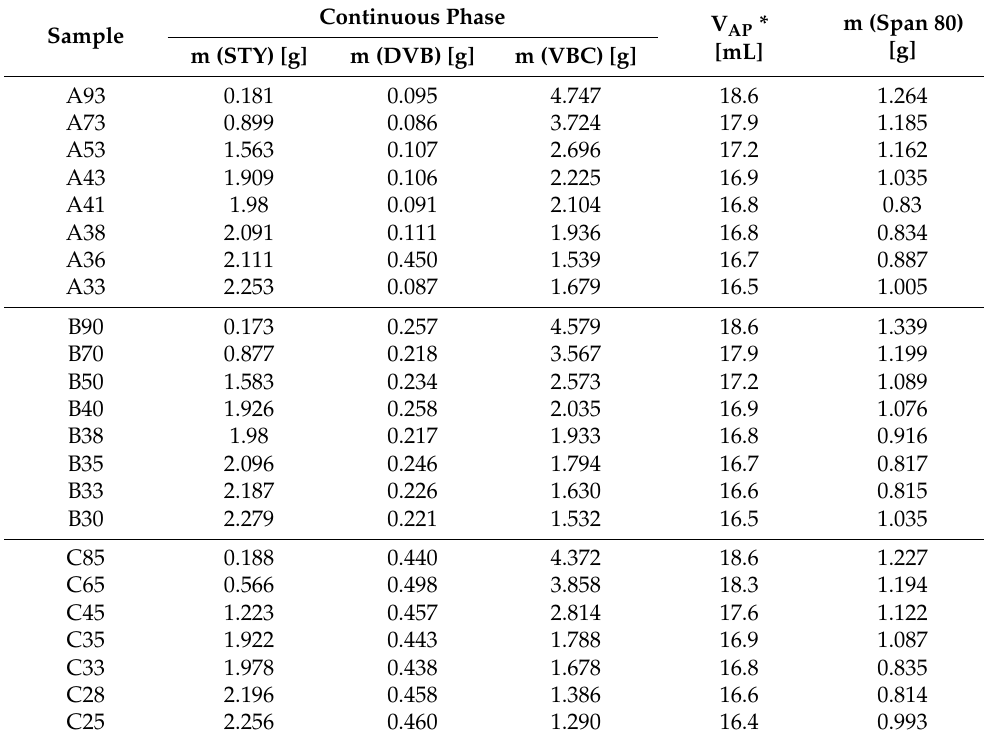
Table 1. Composition of poly (4-vinylbenzyl chloride (VBC)/divinylbenzene (DVB)/ styrene (STY)) poly(high internal phase emulsions) (polyHIPE)